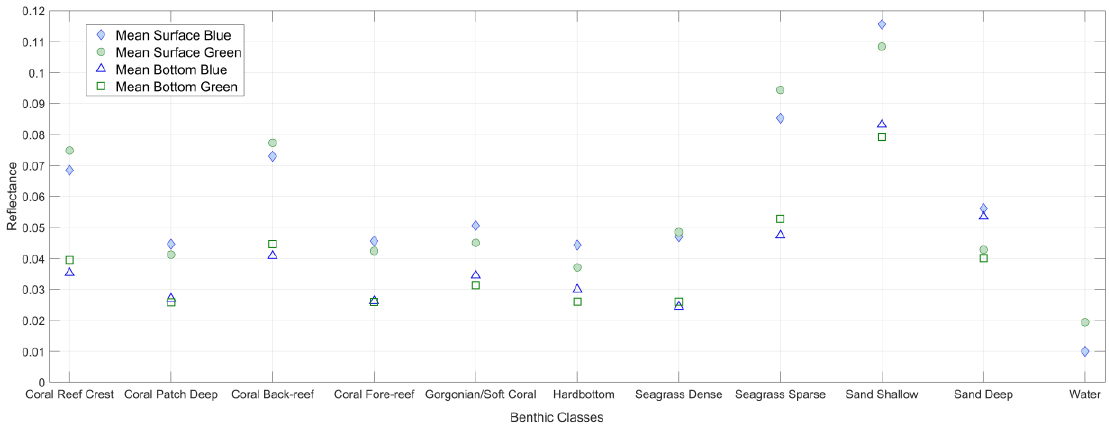
Figure 6. Mean surface reflectance and mean bottom reflectance of different benthic classes.